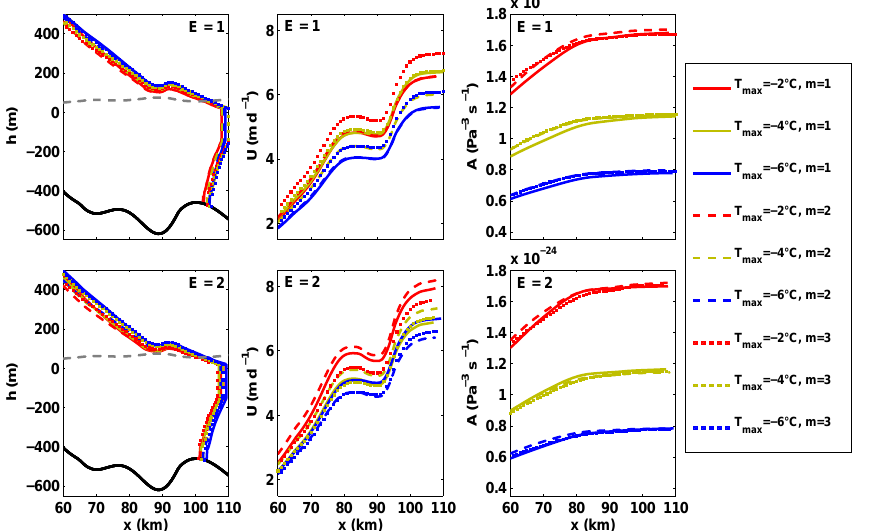
Fig. 4. Initial stable profiles of the (left panels) ice surface elevation, (center panels) speed, and (right panels) rate factor for the 18 model simulations performed using the over-deepened bed